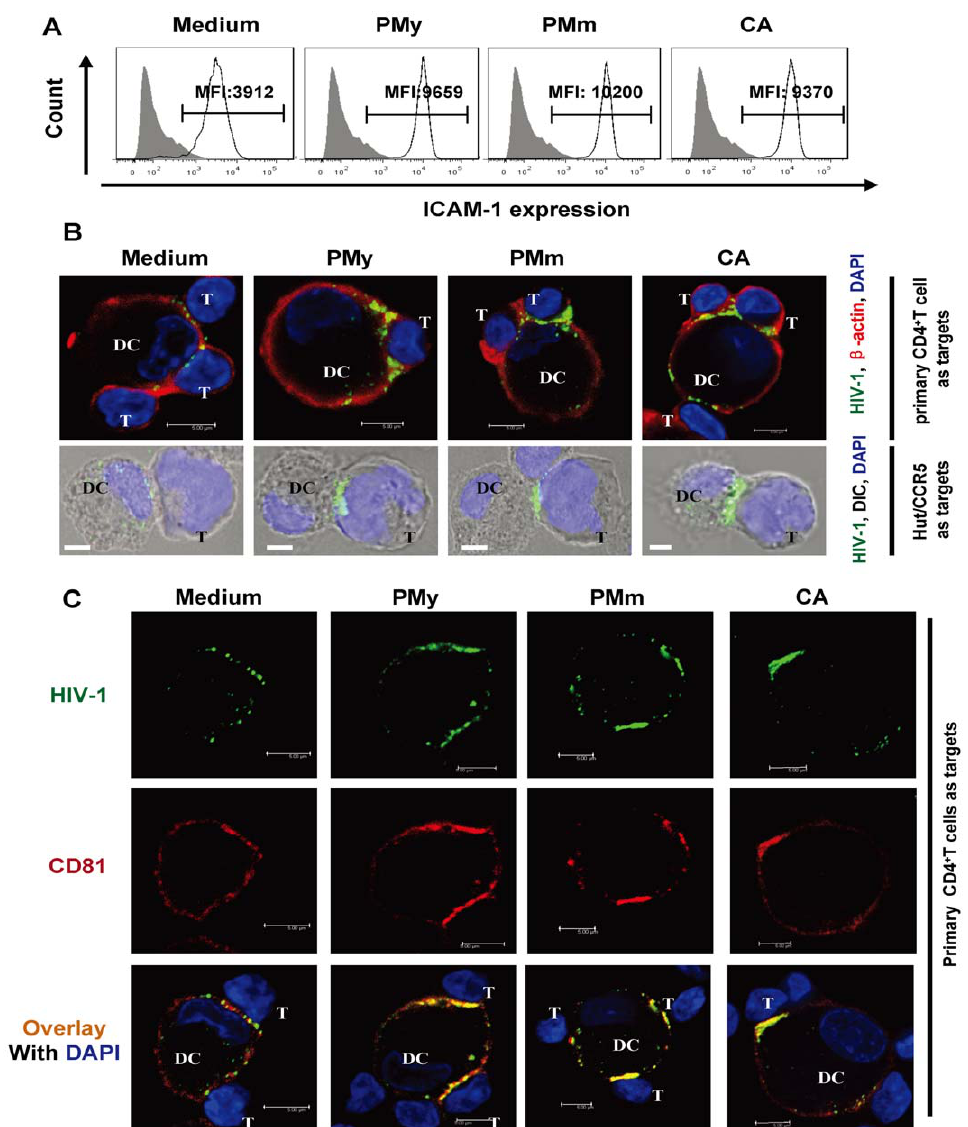
Figure 5. Fungus-stimulated MDDCs increase surface expression of ICAM-1 and facilitate the formation of virological synapses between MDDCs and CD4 + T target cells. (A) Increased ICAM-1 expression on fungus-stimulated MDDCs. Immature MDDCs were treated separately with heat-inactivated C. albicans , PMy and PMm or medium. The surface level of ICAM-1 was detected by flow cytometry. The MFI values are shown. (B, C) Enhanced viral concentration on the contact sites between MDDCs and T cells. Immature MDDCs were treated with fungi as above, HIV-1 VLPs (40 ng p24 gag ) were added for 2 h incubation, and Hut/CCR5 or PHA-activated autologous primary CD4 + T cells were added as target cells for 30 min co-culture. Cells were fixed and observed by confocal microscopy. b -actin (B) or tetraspanin CD81 (C) were stained and shown in red. Nuclei were stained by DAPI. DIC, differential interference contrast. Scale bars, 5 m m.